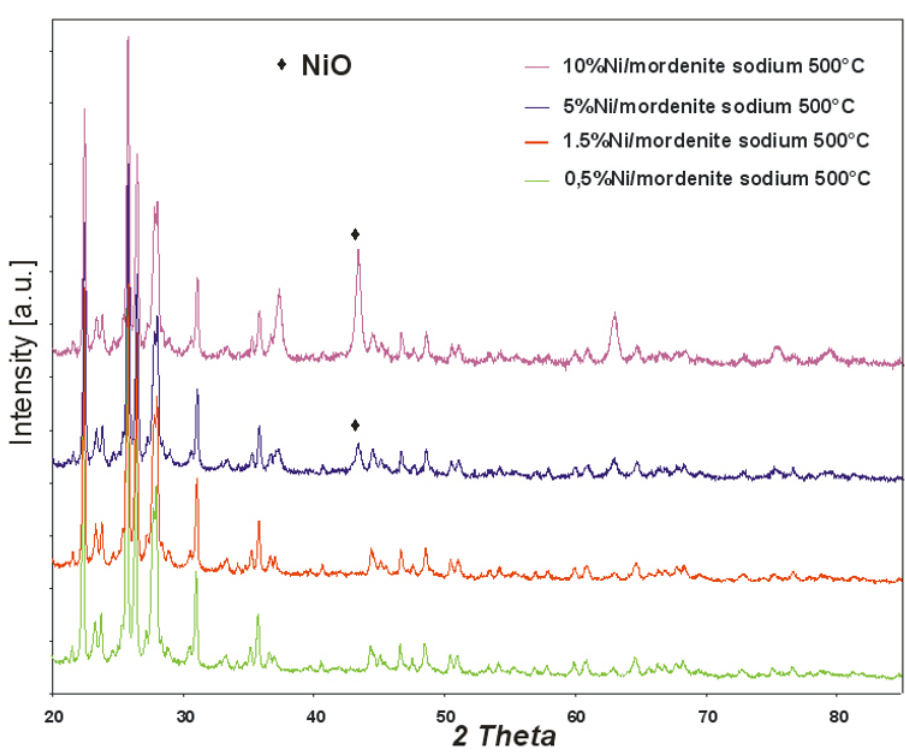
Figure 3. XRD patterns for catalysts after calcinations for 4 h in air atmosphere at 500°C Ni/Na-Mordenite